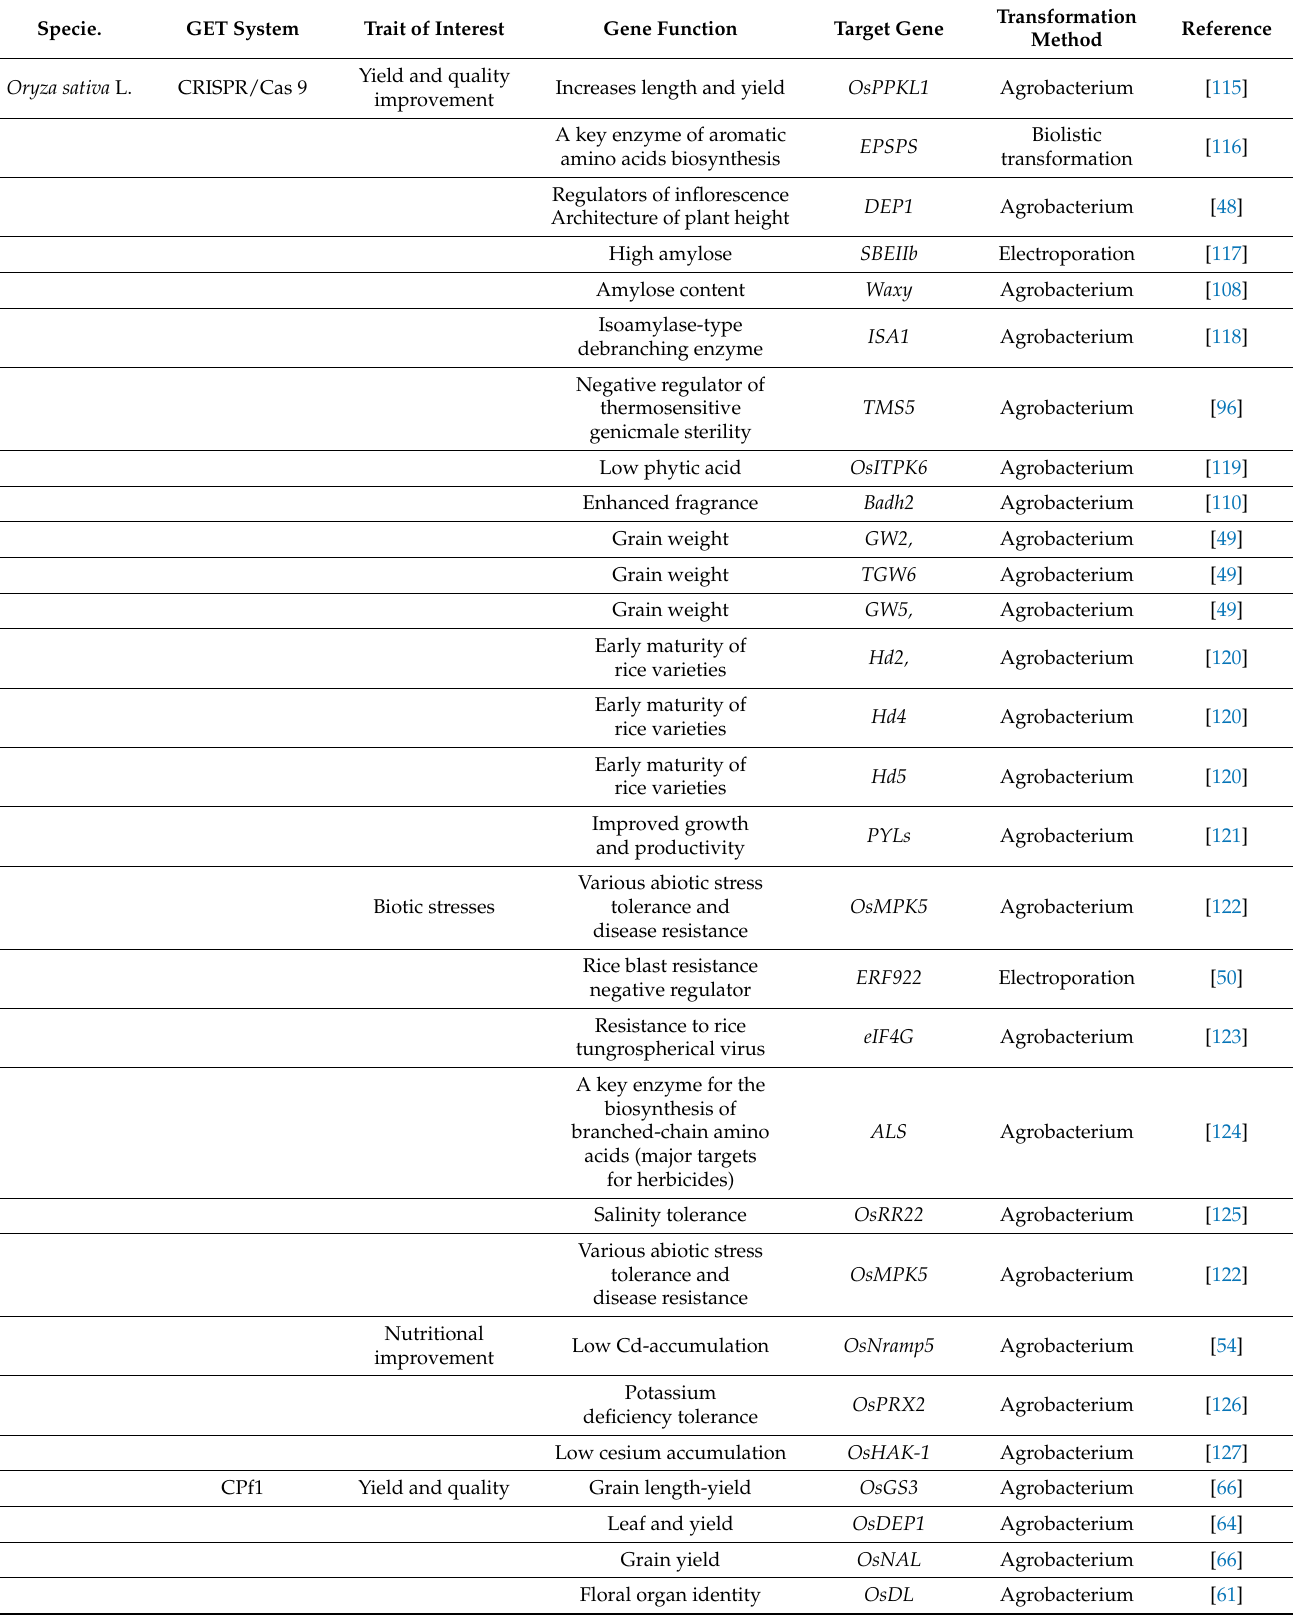
Table 2. List of genes edited through the application of CRISPR/Cas9, Cpf1, base editing, and prime editing systems in plants. Specie. GET System Reference Oryza sativa